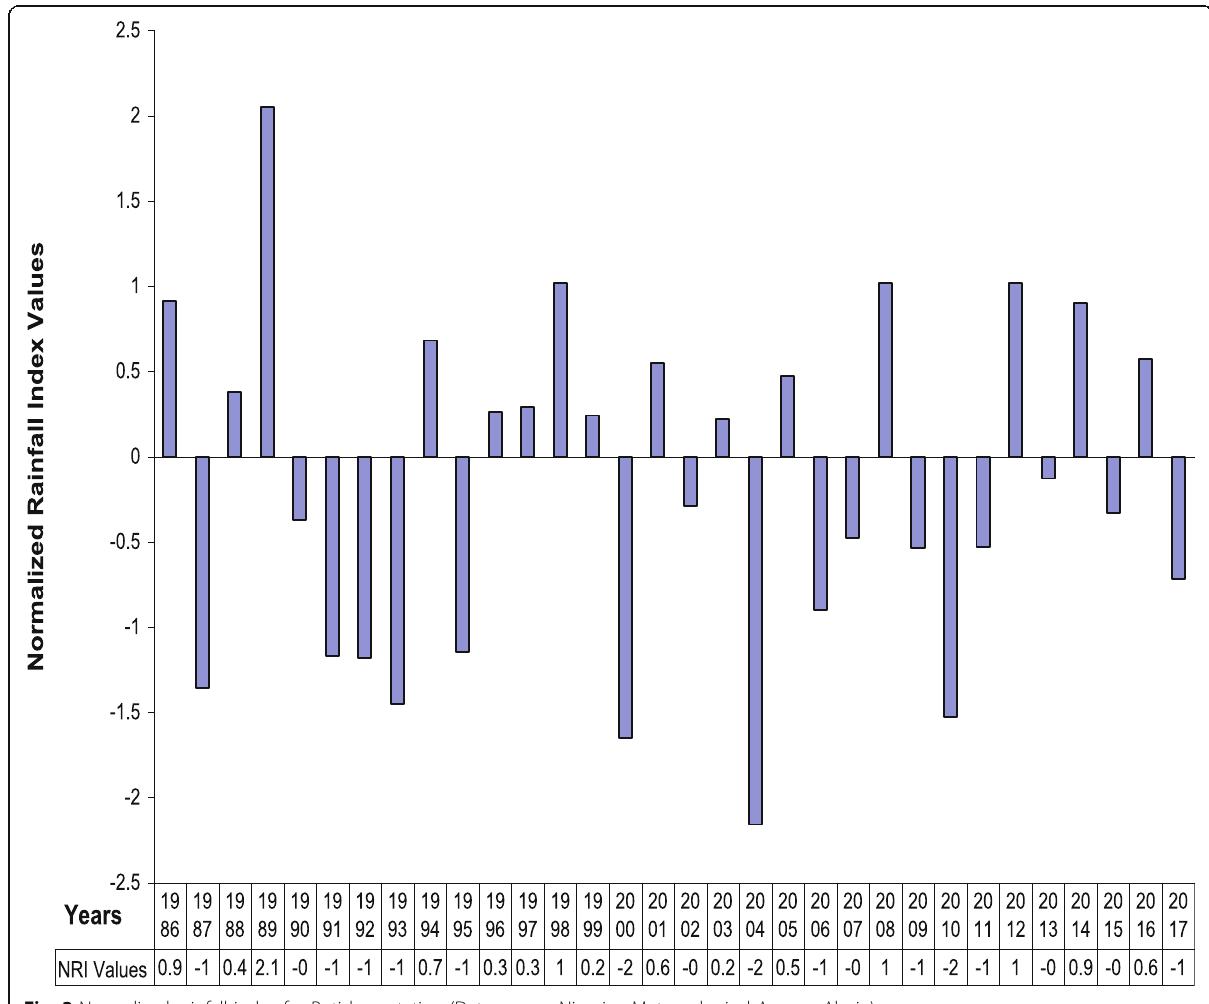
Fig. 3 Normalized rainfall index for Potiskum station (Data source: Nigerian Meteorological Agency Abuja